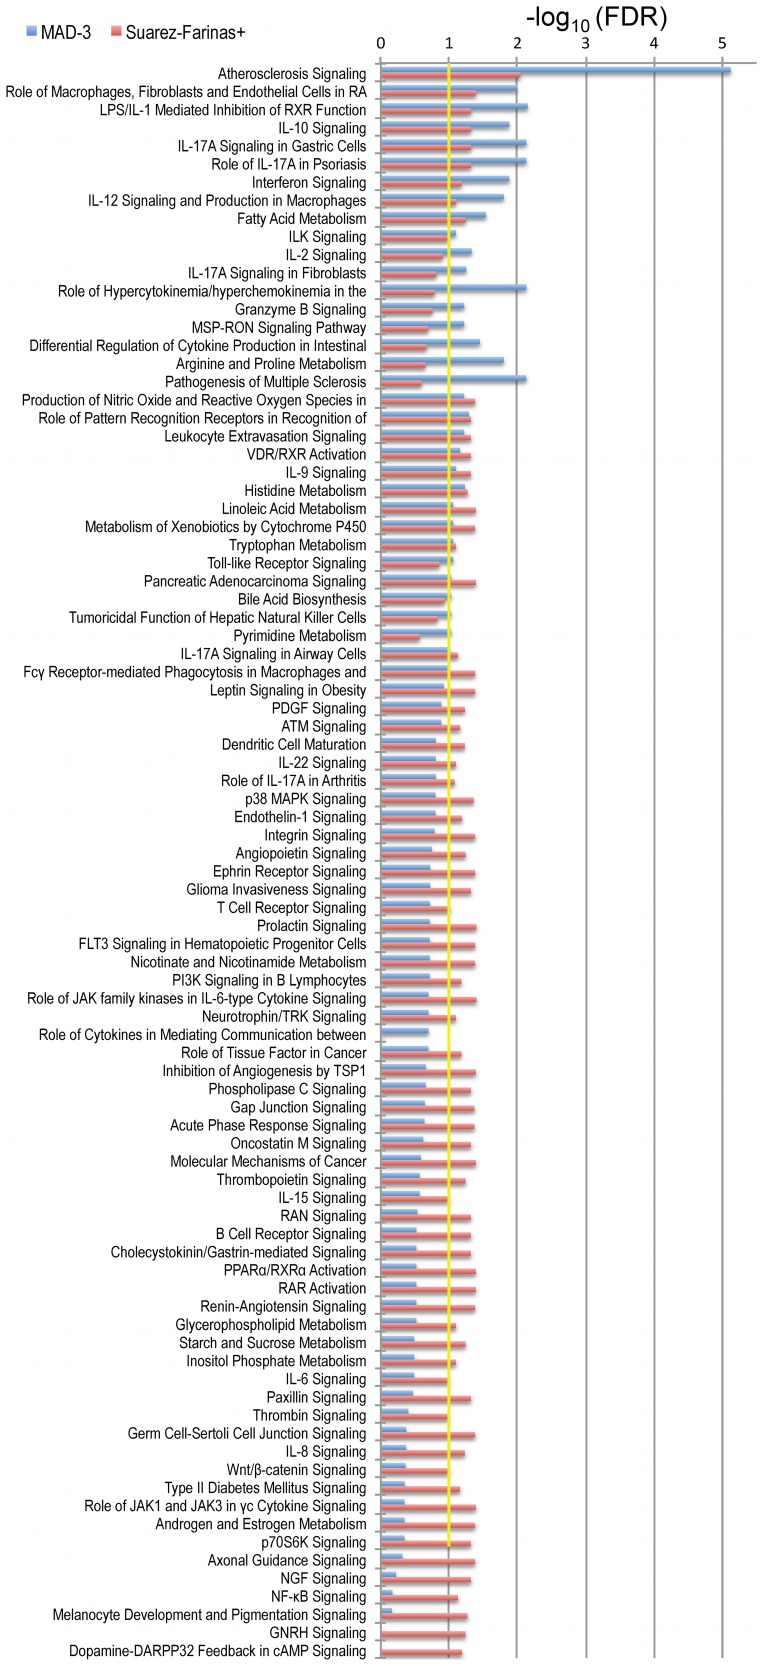
Ingenuity Pathway Analysis.Comparison of canonical pathways overrepresented in MAD-3 transcriptome (blue bars) and Suarez-Farinas+ (red bars), which is the study with the largest sample size and number of DEG. Bars represents a –log10 transformation of the Benjamini-Hochberg adjusted p-value, which controls FDR. Only pathways with FDR<0.1 (which corresponds to 1 in the –log10 scale; represented by yellow line) in either MAD-3 or Suarez-Farinas+ are shown.